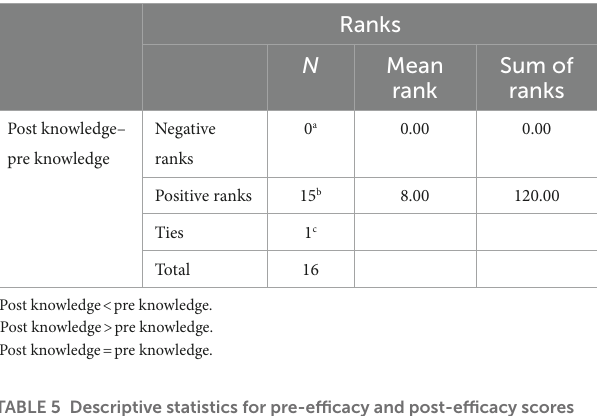
TABLE 4 Negative, positive, and tied paired differences of PST knowledge for scaffolded group.